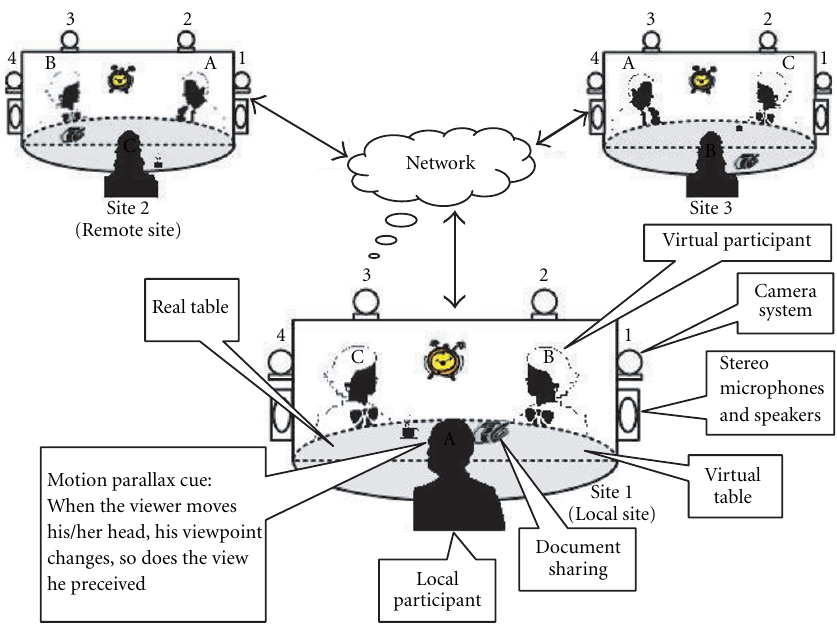
Figure 2: Illustration of the networked VIRTUE station in a three-way telepresence video conferencing session. Assuming accurate 3D scene analysis, the technique behind the novel view generation is the focus of the current paper. Tour into a